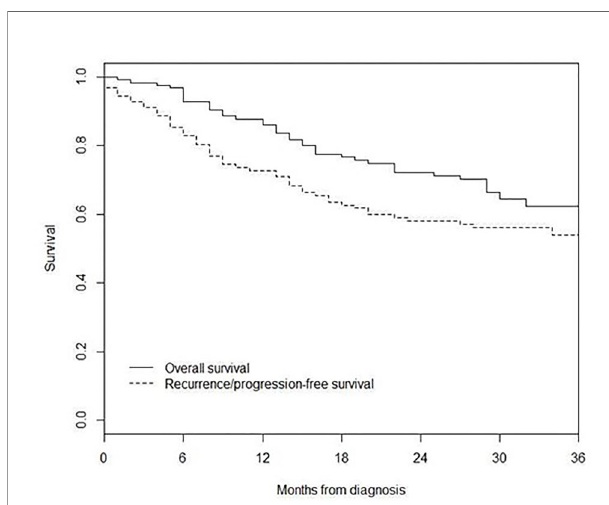
FIGURE 3 | Overall survival and recurrence/progression-free